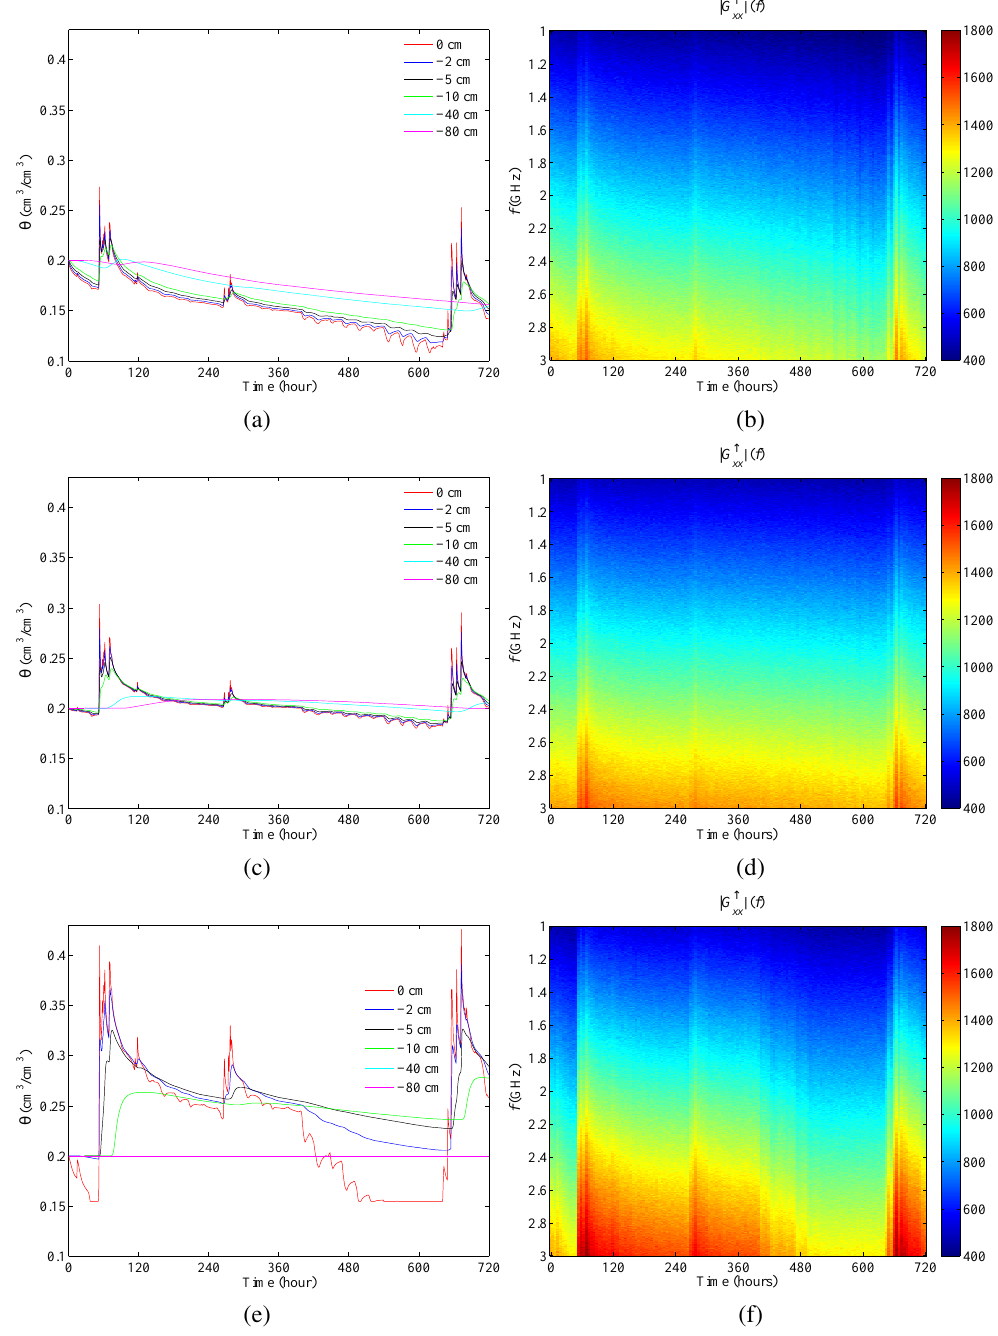
Fig. 3. (a, c, e) Temporal variation of the “true” soil moisture at several depths of the profile (0, 2, 5, 10, 40 and 80cm) and (b, d, f) corresponding “observed” frequency-domain absolute Green’s functions | G 720-hour simulation period. The results were obtained using the three soil types: (a, b) loamy sand, (c, d) silt and (e, f) clay. adding Gaussian random perturbations to the synthetic GPR data. The mean of the perturbations is set to zero and its stan- dard deviation is equal to the variance components of the ob- servation error covariance matrix.